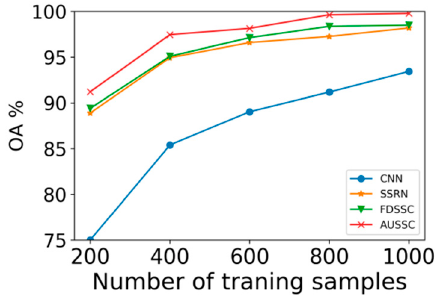
Figure 15. The overall accuracy (OA) of different methods for different numbers of training samples in the Houston data set.